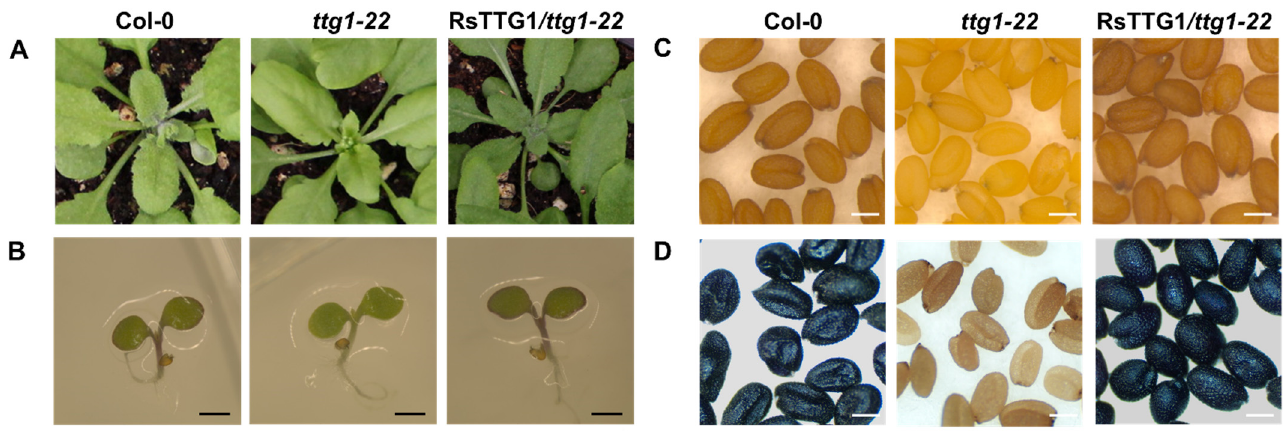
Figure 3. Complementation analysis of RsTTG1 in the Arabidopsis ttg1-22 mutant. Three-week-old seedlings ( A ), five-day-old seedlings ( B ), mature seeds ( C ), and DMACA-stained mature seeds ( D ) of wild type (Col-0), ttg1-22 mutant, and T 3 progeny of ttg1-22 homozygotes transformed with RsTTG1 . Black Bars, 1 mm. White Bars, 0.25 mm.